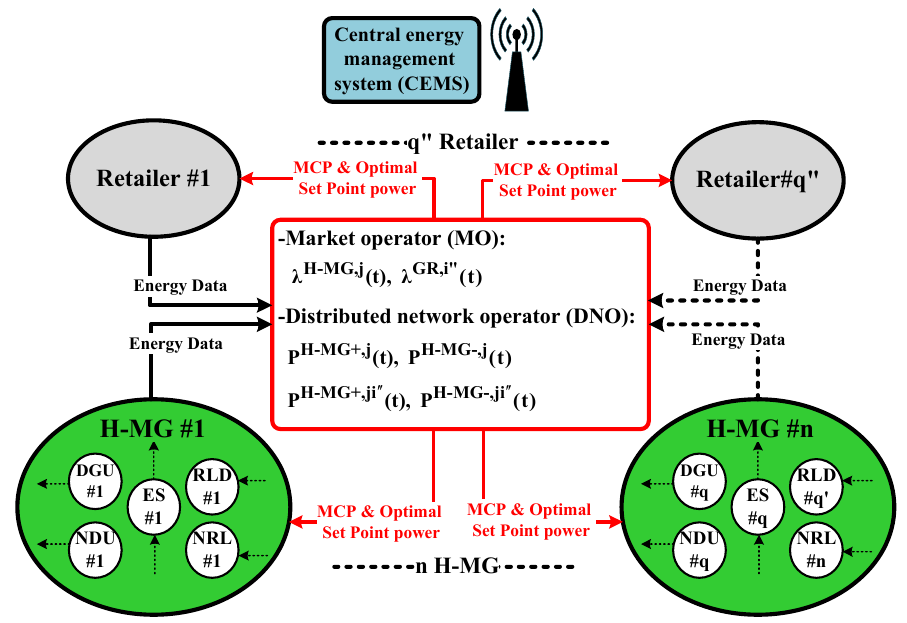
Figure 2. Interaction of distributed network operator (DNO), market operator (MO) and MH-MGs. Central energy management system (CEMS), non-responsive load (NRL), market clearing price